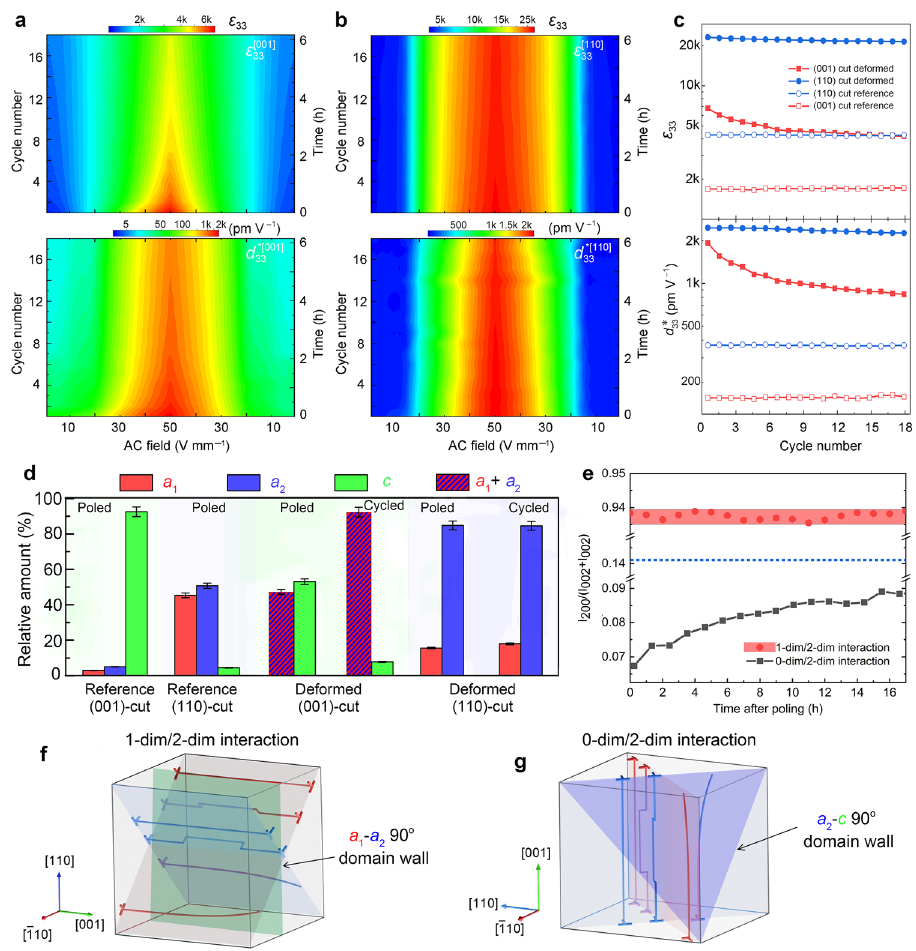
Fig. 3 | Dislocation-induced stability and anisotropic DDW interactions. Rela- tive dielectric permittivity, ε 33 and piezoresponse, d 33 * during cycling measure- ments at 1kHz for a (001)-cut deformed and b , (110)-cut deformed samples. c ε 33 and d 33 * at 50Vmm – 1 as a function of cycle number for both (001)- and (110)-cut samples. d Comparison of the domain distribution of both (110)- and (001)-cut samples poled at 1kVmm – 1 , and after cycling, determined from NMR spectra. Green color indicates the c -domains with polarization vector pointing toward [001],namely,perpendiculartotheoriginalmechanicalloadingaxis.Redandblue colors refer to the a 1 -domains (polarization vector pointing toward [100]) and a 2 - domains (polarization vector pointing toward [010]). Therefore, for (110)-cut samples, out-of-plane domains refer to a 1 (red) and a 2 (blue), in-plane domains